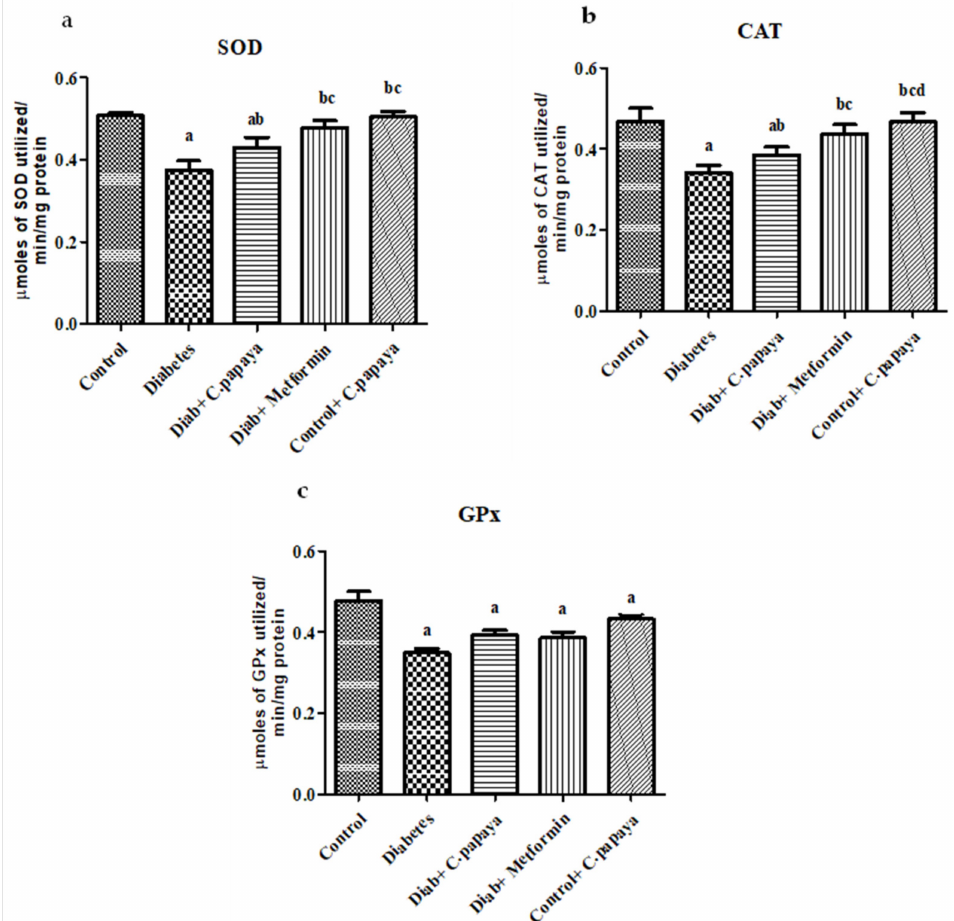
Figure 7. ( a – c ) Enzymatic antioxidant levels in the ethanolic extract of C. papaya in the control and diabetic rats. Each bar indicates the mean ± SEM of eight rats, with p < 0.05 indicating significant differences between the groups as: a—control; b—diabetes; c—diabetic rats treated with ethanolic extract of C. papaya ; and d—diabetic rats treated with